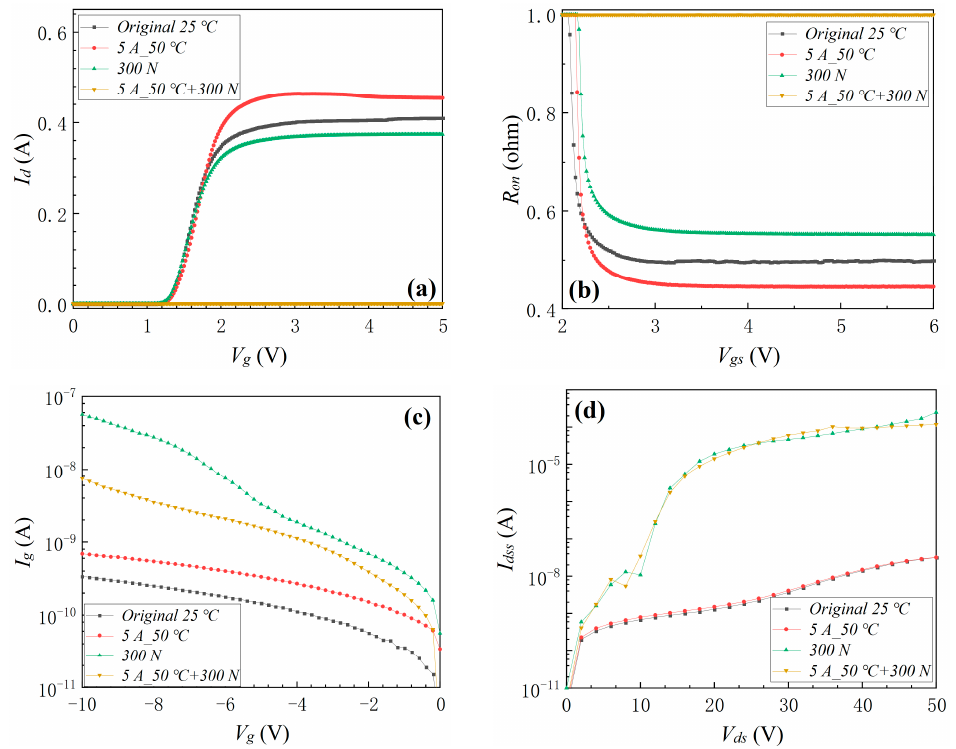
Figure 10. The device’s transfer characteristic ( a ), R on ( b ), I g ( c ), and I dss ( d ) before and after electro-thermo-mechanical coupling stress.